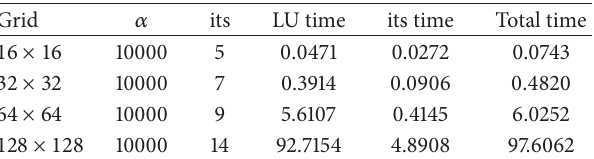
Table 11: Preconditioned GMRES(20) on steady Oseen problems with different grid sizes (uniform grids), viscosity V = 0.01 .